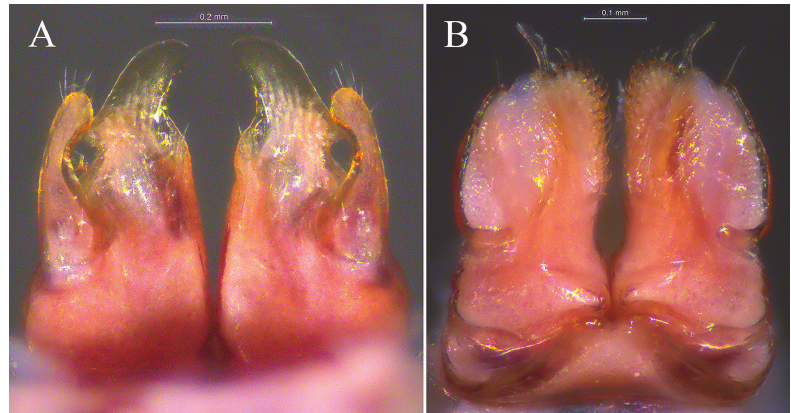
Figure 9. Glyphiulus calceus sp. n., holotype. A anterior gonopods, caudal view B posterior gonopods, caudal view.